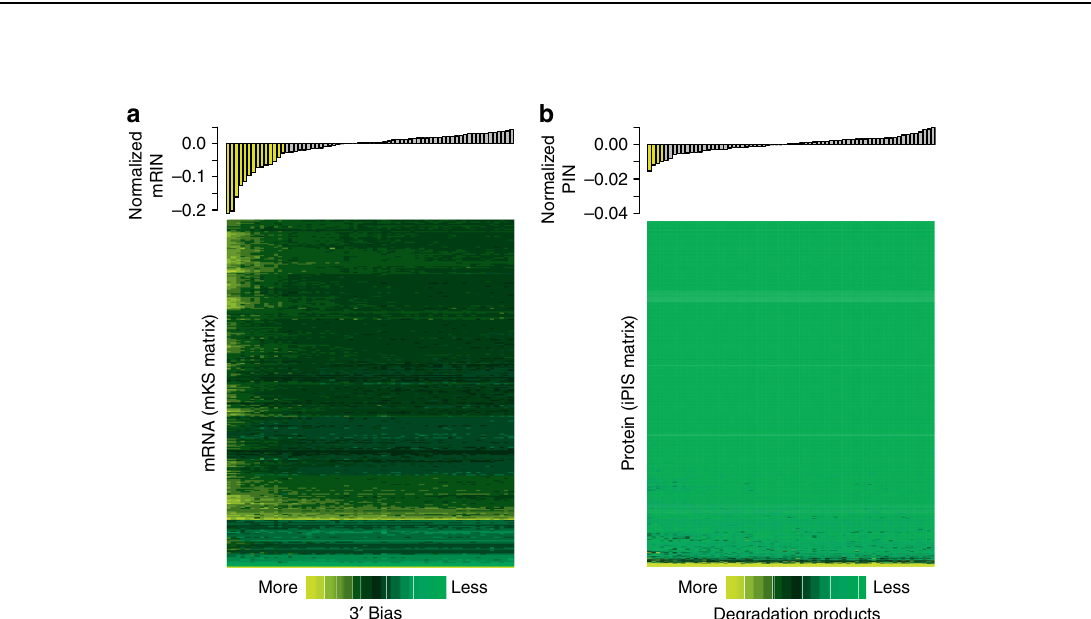
Fig. 4 Visualization of degradation at the level of individual transcripts and proteins. a Heatmap (bottom) of mKS matrix illustrating the degree of degradation of each individual transcript (rows), with samples (columns) ordered by mRINs. The bar plot (top) displays each sample ’ s mRIN (median centered). Samples with signi fi cant mRNA degradation are highlighted in yellow in the bar plot ( n = 68). b Similar to a , but for iPIS matrix with samples ordered by the PIN values. Four samples with signi fi cant protein degradation are highlighted in yellow in the bar plot ( n = 68)